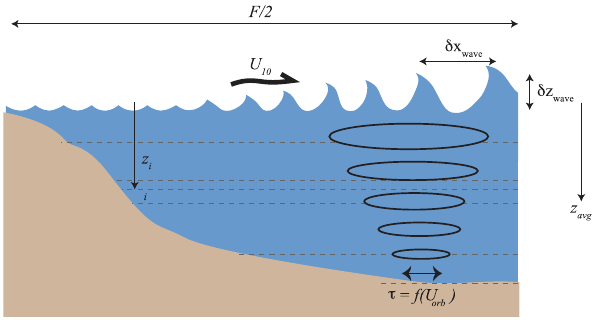
Figure 14. Schematic of the wave estimation approach depicting the lake fetch, surface wind speed, wave height, wavelength, and bottom stress created by the orbital